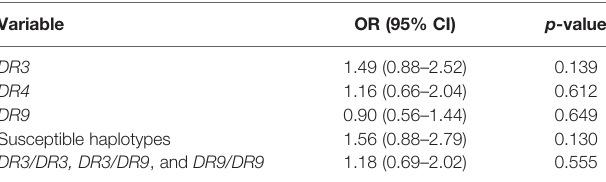
TABLE 5 | Association of the frequency of GAD65-CAb with the frequencies of HLA-DR-DQ haplotypes and genotypes. Variable